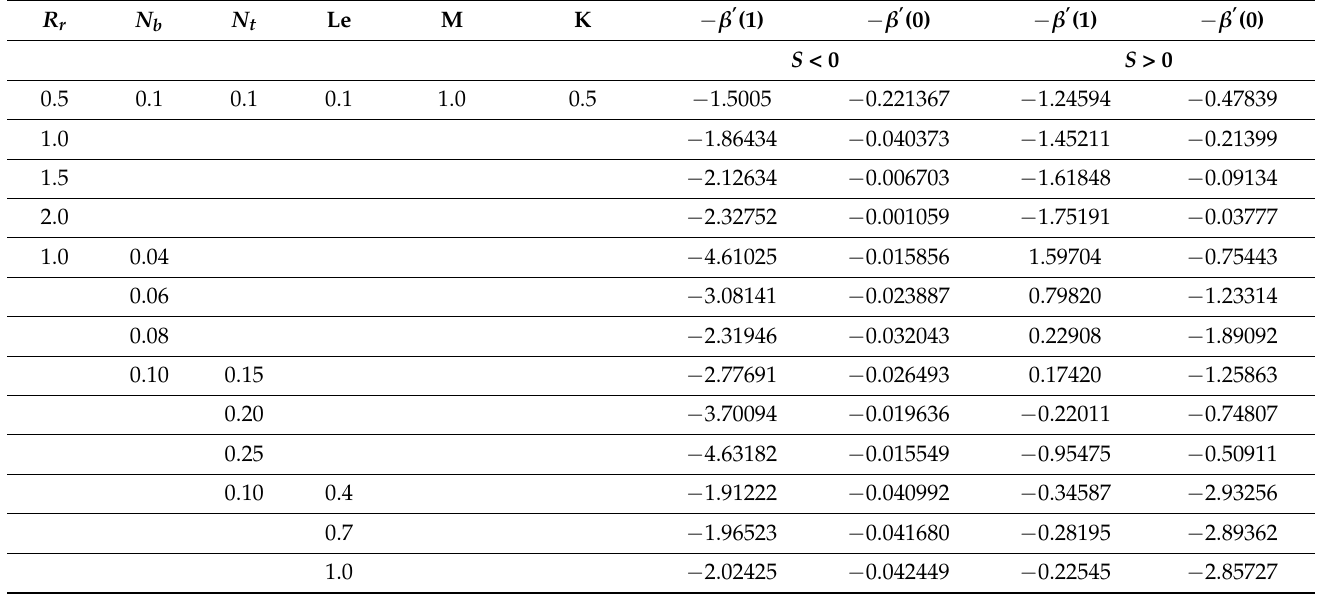
Table 11. Local Sherwood number for γ Al 2 O 3 − H 2 O at lower and upper plane with weak interaction n = 0.5.